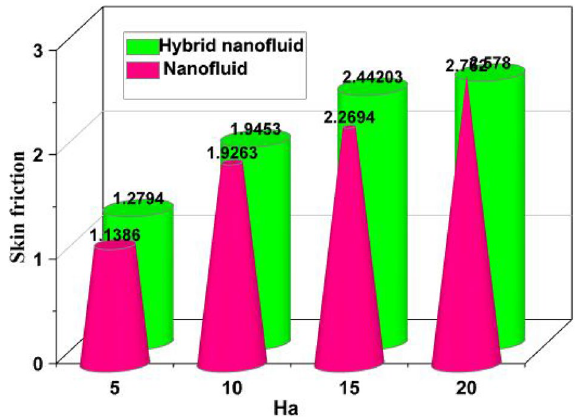
Figure 9. Skin friction versus Ha.